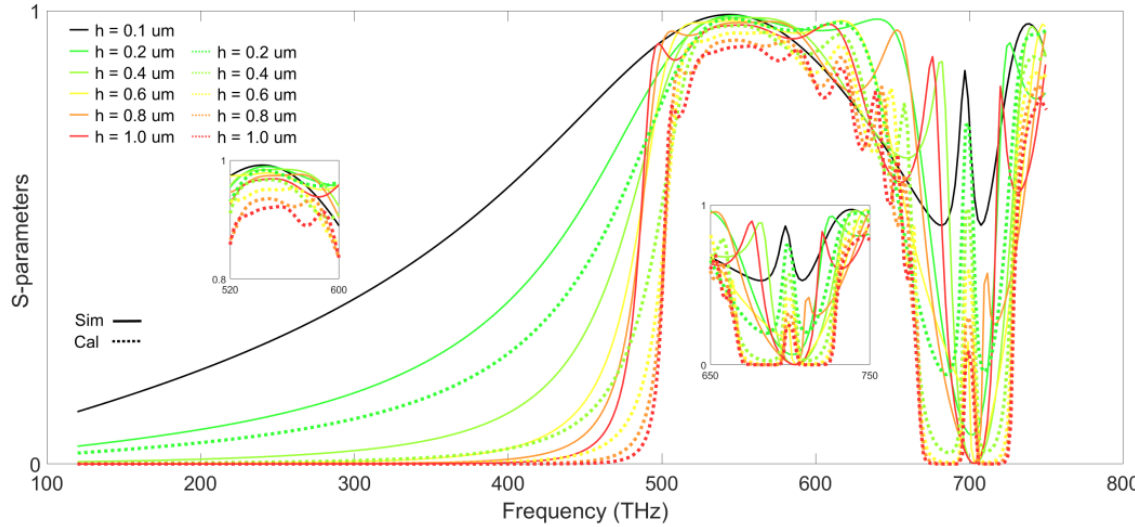
Figure 5. Cascade response when only containing metallic film (Au) on 120 – 750 THz band, wherein the black curve is the case with a thickness of 0.1 um, that is, the cascade benchmark.